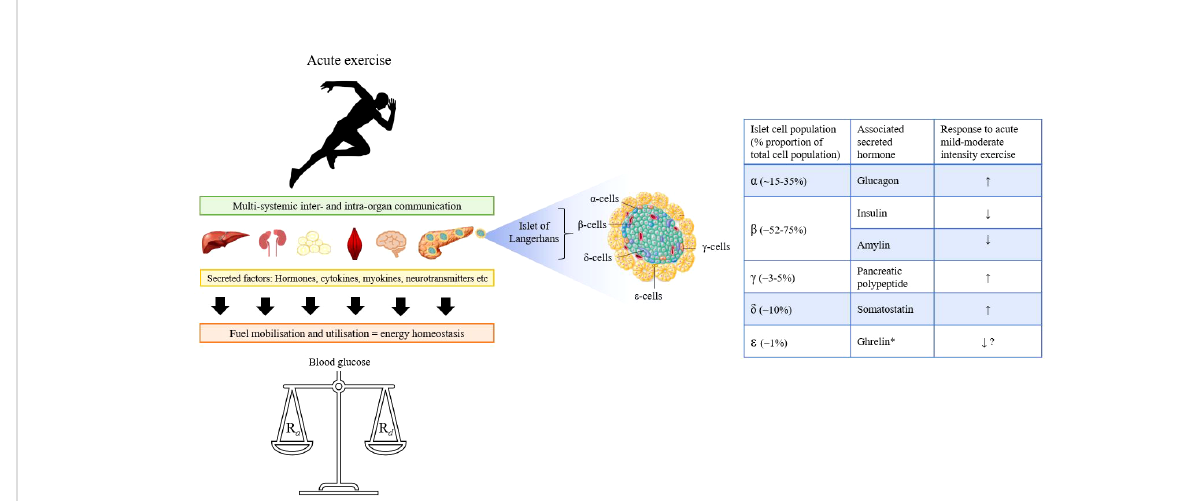
FIGURE 1 Graphical overview of the multi-systemic effects of exercise involving communication across multiple organs to ensure energy homeostasis and regulation of blood glucose in healthy persons. Blood glucose is a dynamic state of constant turnover and multiple feedforward and feedback mechanisms operate to balance the rate of glucose appearance (R a ) with its disappearance (R d ) during exercise. Central to this process is the pancreas, which contains fi ve major islet-cell populations each of which secrete their associated hormone(s) depending on the metabolic requirements. *Note: Ghrelin is only produced to a very limited extent in the